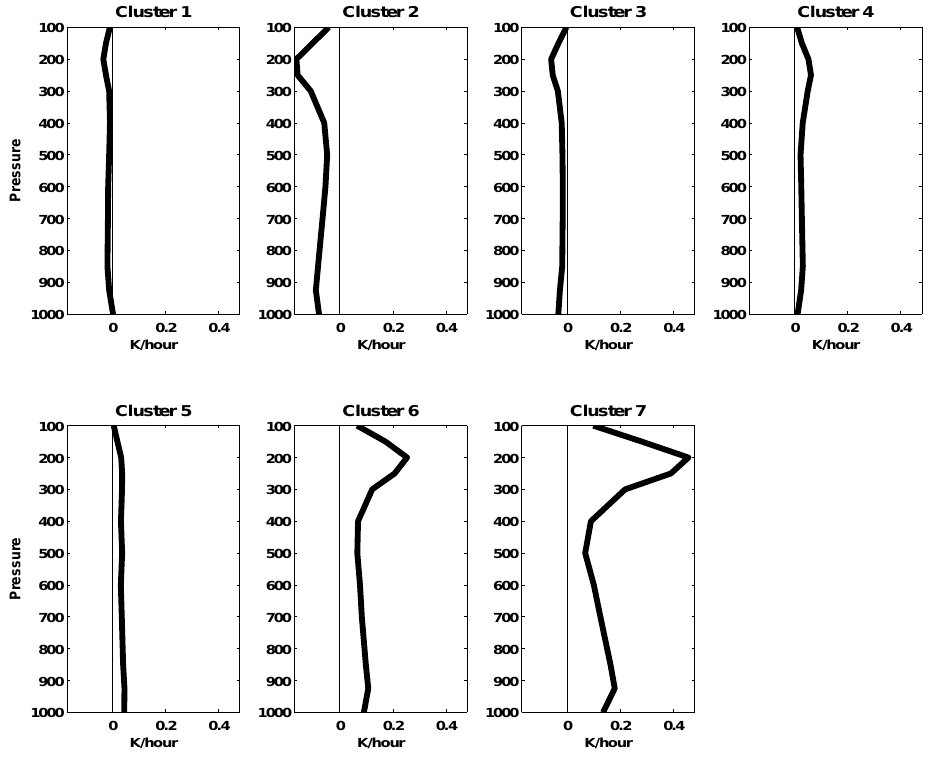
Fig. 6. As in Fig. 2, except for perturbation horizontal temperature